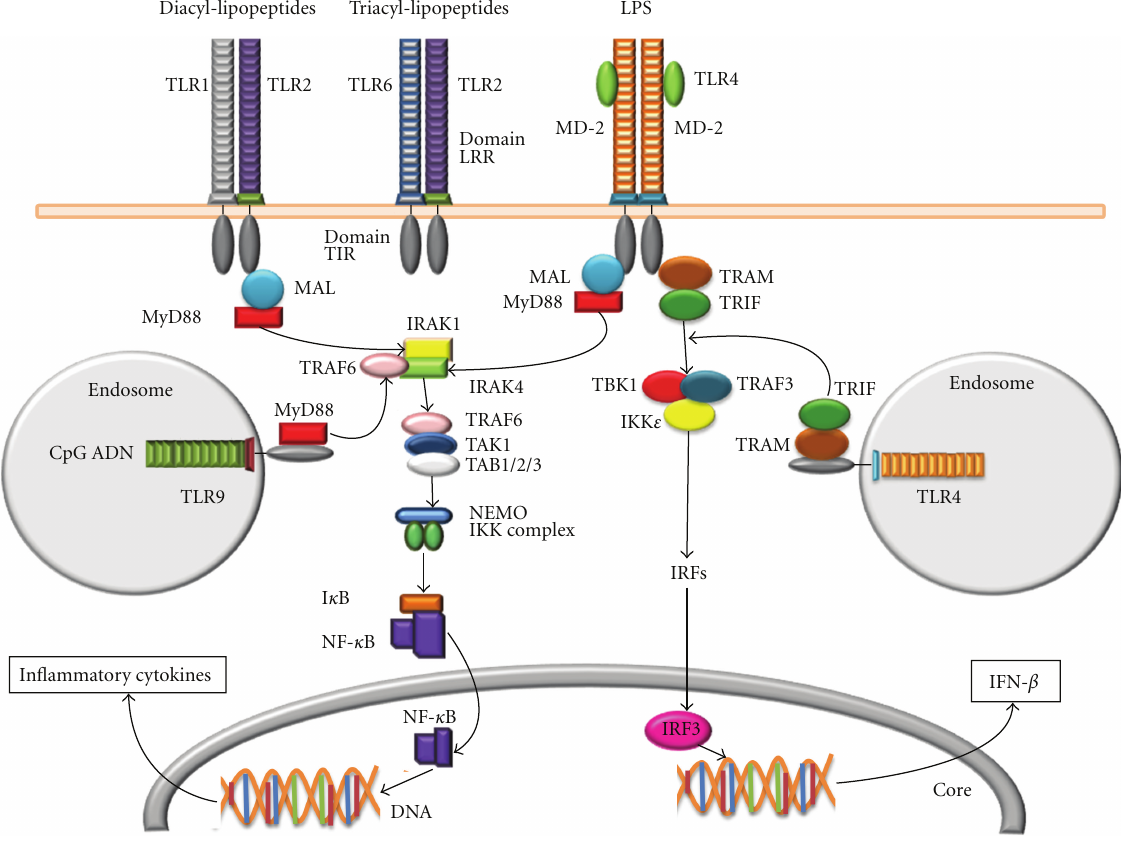
Figure 2: TLRs signaling pathways involved in the recognition of Mtb structures.TLR receptors can recognize several conserved molecular patterns of the mycobacteria cell wall. Diacylated or triacylated proteins as well as LPS are recognized by membrane receptors (TLR1, TLR2, TLR6, and TLR4), whereas bacterial unmethylated CpG DNA can be recognized by endosomal TLR9. MyD88 adaptor is a central component in TLR signaling whose downstream signaling cascade leads to the activation of NF-kB and AP-1 transcription factors and to the production of inflammatory cytokines. Signaling through TRIF adaptor molecule activates IRF-3 transcription factor inducing IFN- β